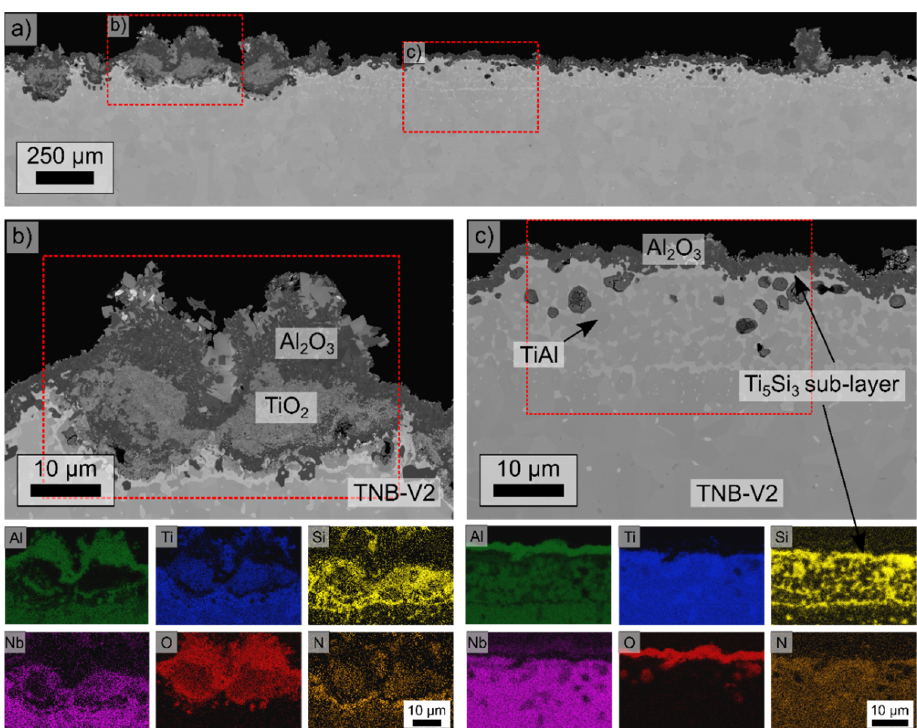
Figure 13. SEM cross sections of the Al-12Si (in at.%) coating on a TNB-V2 alloy after 5000 cycles of oxidation at 900 °C as overview ( a ) and two regions with corresponding EDS elemental mappings of the red marked areas in detail (( b ) and ( c )).